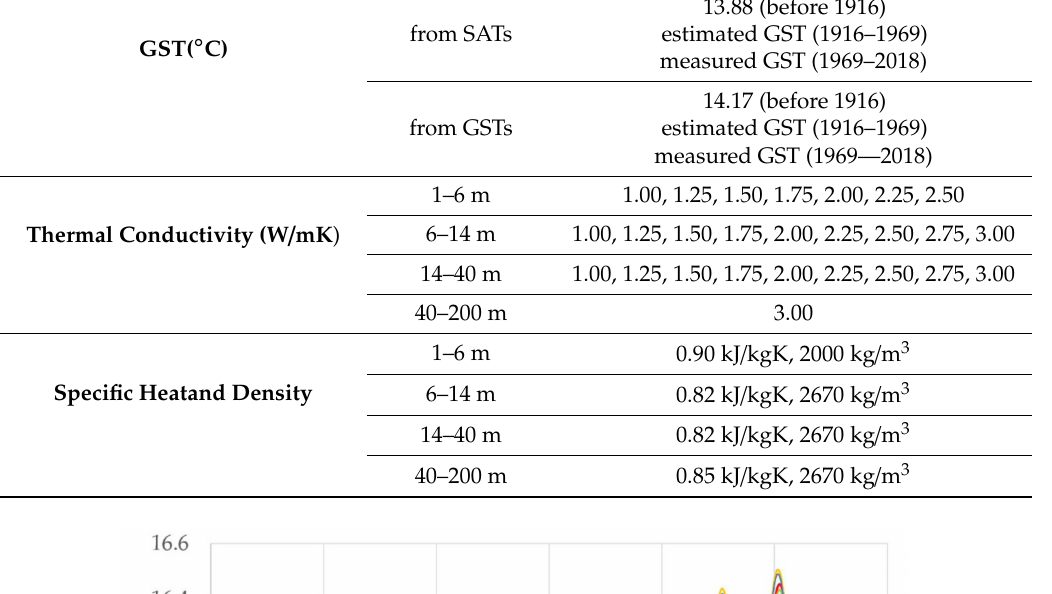
Table 2. Summary of GST and thermal property data used for simulation.